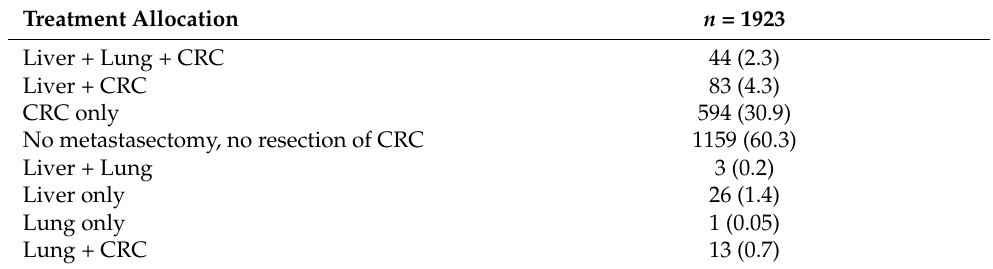
Table 3. Treatment allocation in 1923 patients diagnosed with liver and lung metastases within six months from diagnosis of colorectal cancer in Sweden between 2008 and 2016.